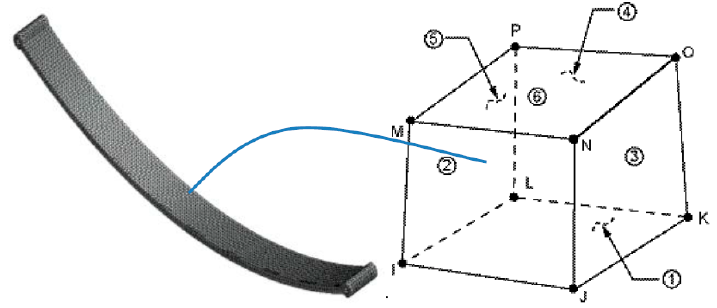
Figure 9. Brick eight node solid 185 meshed model of a mono leaf spring.